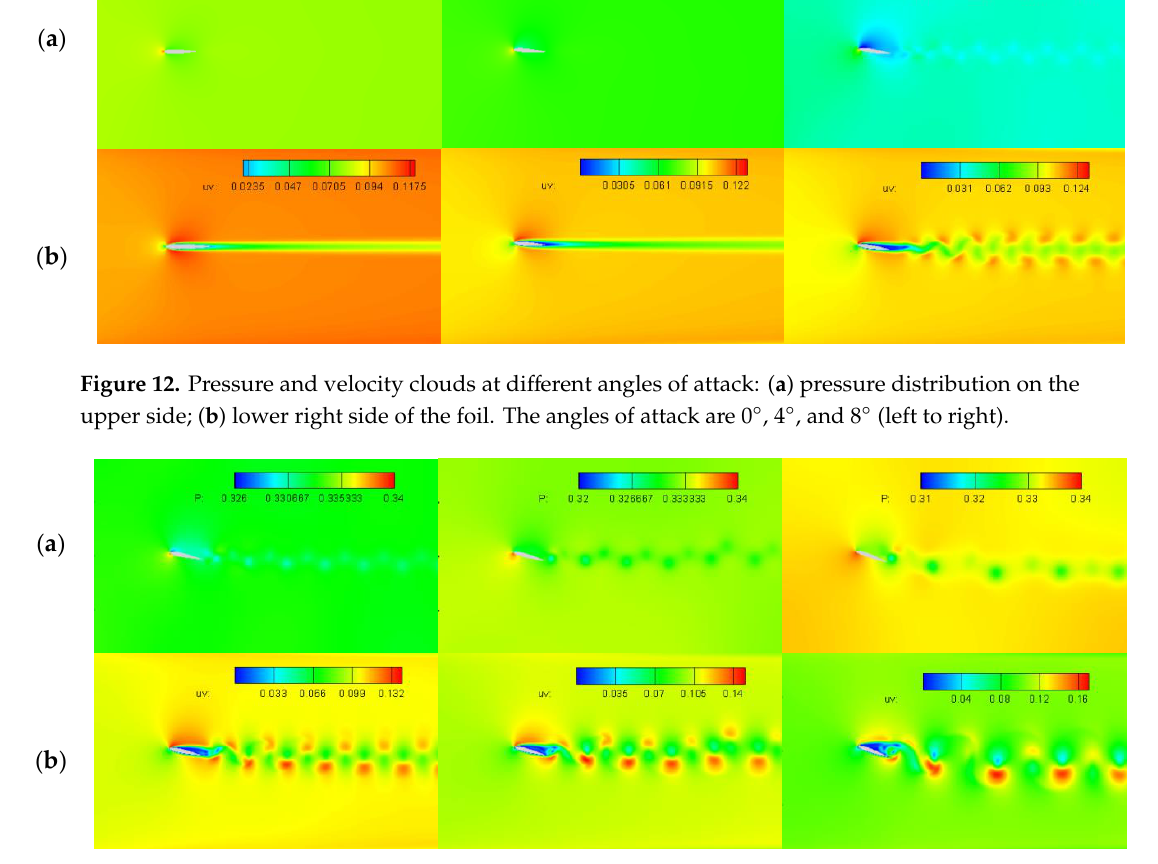
Figure 13. Pressure and velocity clouds at different angles of attack: ( a ) pressure distribution on the upper side; ( b ) velocity distribution on the lower right side of the foil. The angles of attack are 12°, 15°, and 20° (left to right).